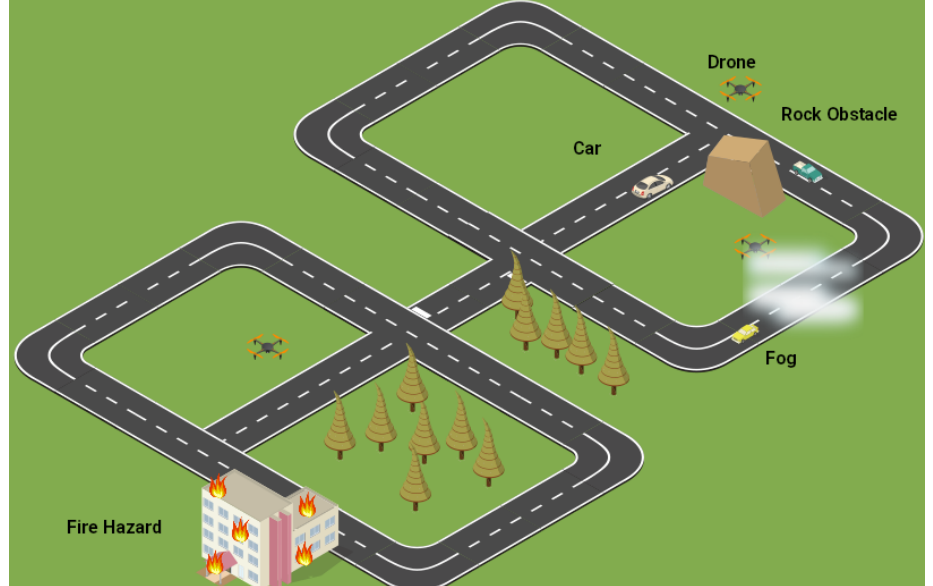
Figure 12. Illustration of the driving environment in the